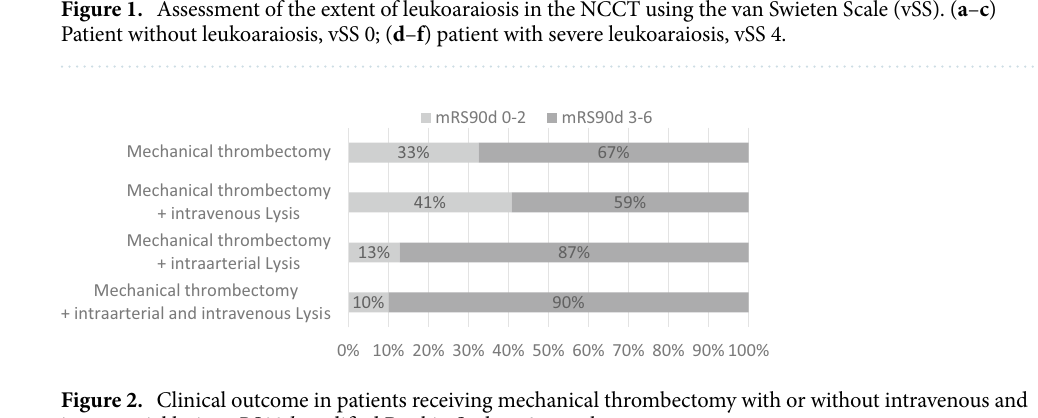
Figure 2. Clinical outcome in patients receiving mechanical thrombectomy with or without intravenous and intraarterial lysis. mRS90d modified Rankin Scale at 3